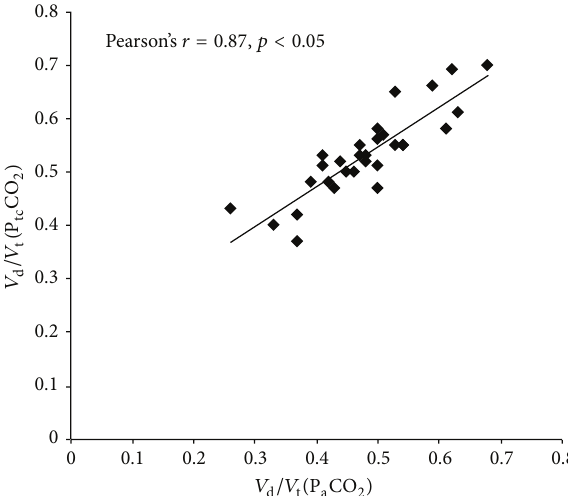
Figure 1: Scatter plot of 𝑉 d /𝑉 t using P a CO 2 against 𝑉 d /𝑉 t using P tc CO 2 .